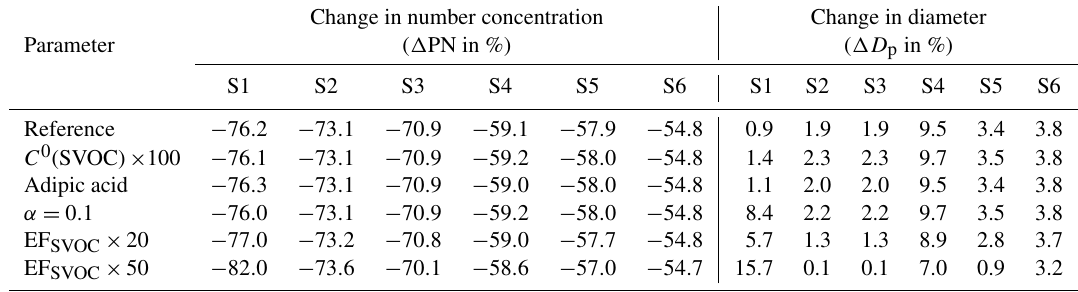
Table 9. Effect of the chosen parameters for the condensing organic vapour(s) in the MAFOR model when simulating the Urban Case scenario (all processes included). The reference is the model run with all processes presented in Sect. 4.1.1. The size ranges of the six size classes are S1: 1–10nm, S2: 10–25nm, S3: 25–50nm, S4: 50–75nm, S5: 75–100nm, and S6: > 100nm.